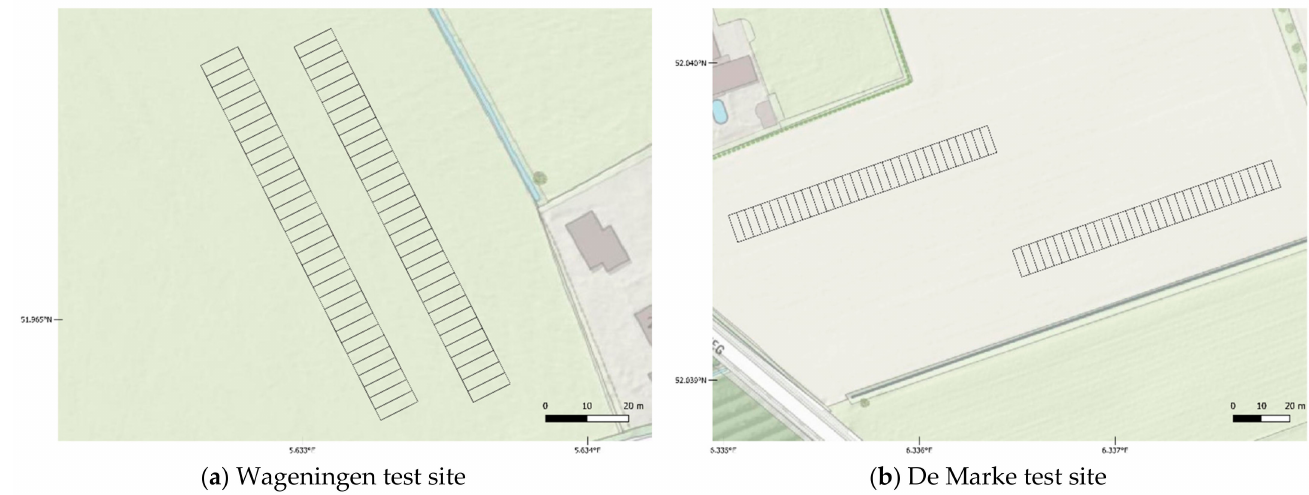
Figure 1. Design of experimental fields: ( a ) Wageningen test site (clay soil); ( b ) De Marke test site (sandy